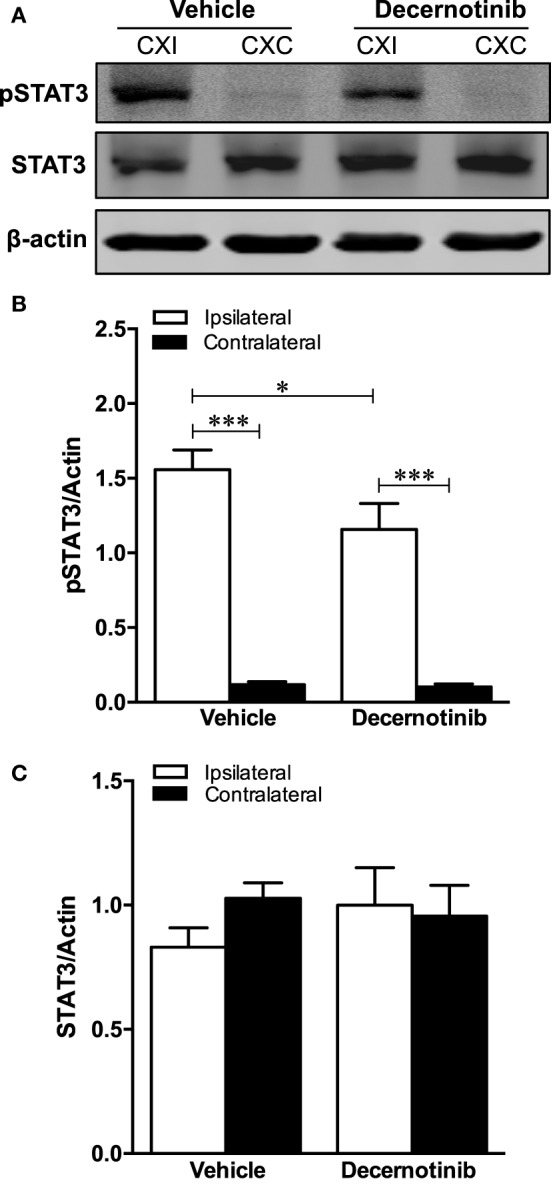
(A) Representative immunoblot of mouse brain tissue. (B) Graphical summary of phosphorylated STAT3 immunoblot data normalized to actin (*P < 0.05; **P < 0.01, vehicle n = 9; 10 mg/kg decernotinib, n = 5). Phosphorylated STAT3 is increased in the ipsilateral cortex compared to the contralateral. Phosphorylated STAT3 is decreased in the ipsilateral cortex with 10 mg/kg decernotinib compared to the vehicle-treated group. (C) Graphical summary of total STAT3 immunoblot data normalized to actin (vehicle, n = 9; 10 mg/kg decernotinib, n = 5). Total STAT3 does not vary between groups.